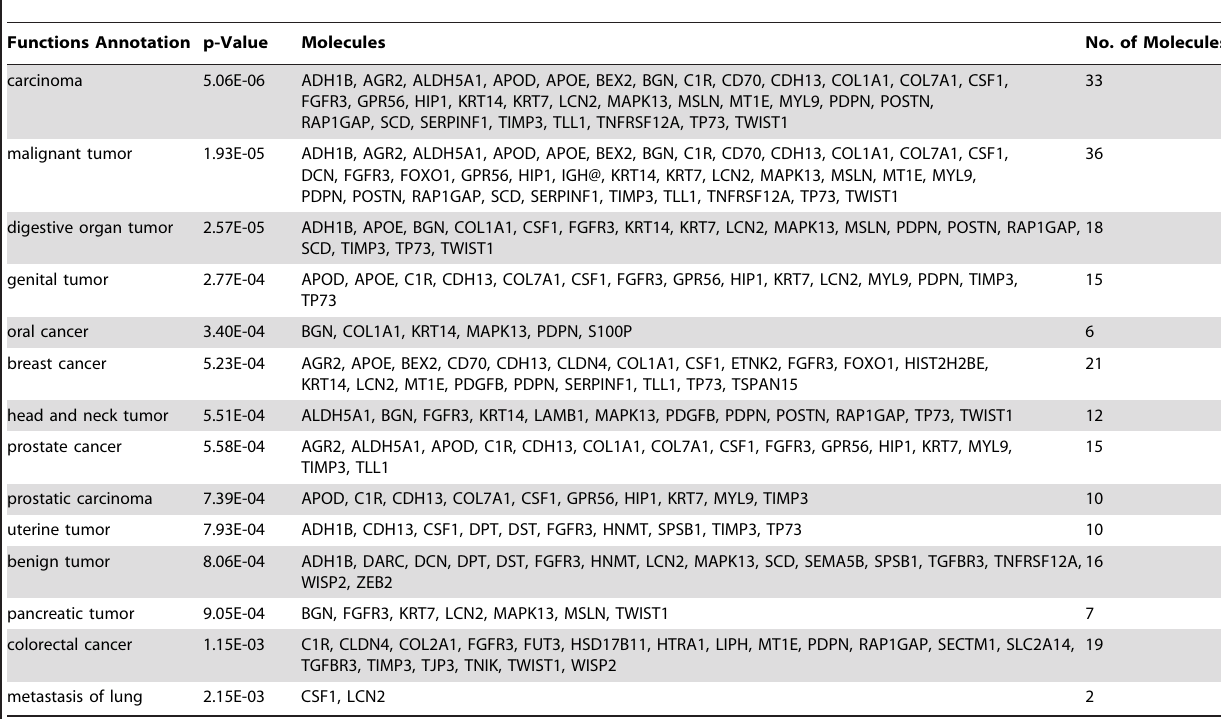
Table 4. Significant consistently differentially expressed genes involved in various types of